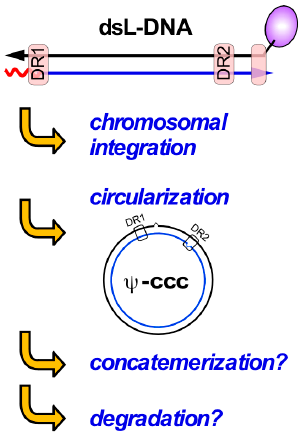
Figure 7. Double-strand linear (dsL) DNA—a free-ended double-strand DNA break mimic? Hepadnaviral dsL-DNA is a common replication by-product from in-situ priming of plus-strand DNA. Like other linear DNAs dsL-DNA likely evokes repair responses that remove the free ends, e.g., by chromosomal integration, circularization (as for retroviral 2LTR-circles), concatemerization and/or exonucleolytic degradation. Circularization appears to occur mainly via error-prone non-homologous end-joining, yielding often defective cccDNA-like molecules ( Ψ -cccDNA). Concatemerization and degradation via exonucleases have not explicitly been demonstrated.